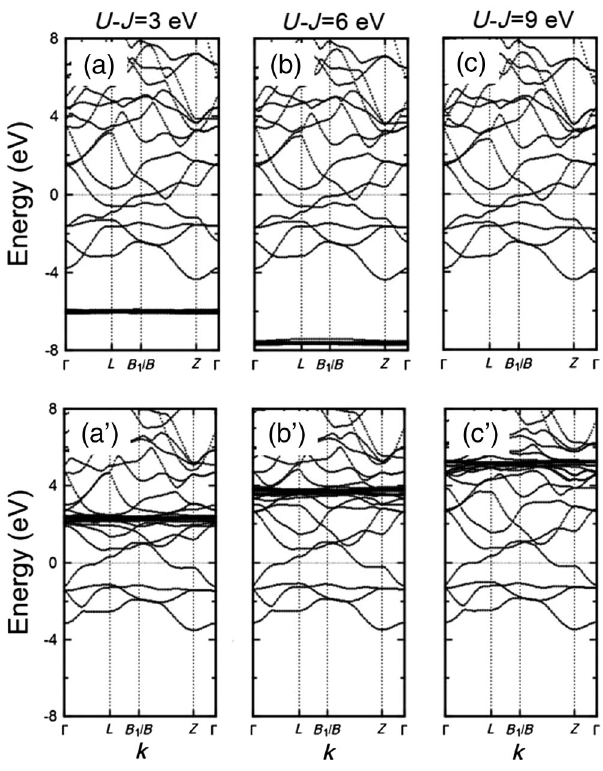
FIG. 14. Band structure for the spin-up electrons of Gd 2 C calculated with (a) U − J ¼ 3 eV, (b) 6 eV, and (c) 9 eV with J fixed at 0.7 eV. Similar plots for spin-down electrons are shown in ( a 0 ), ( b 0 ), and ( c 0 ).